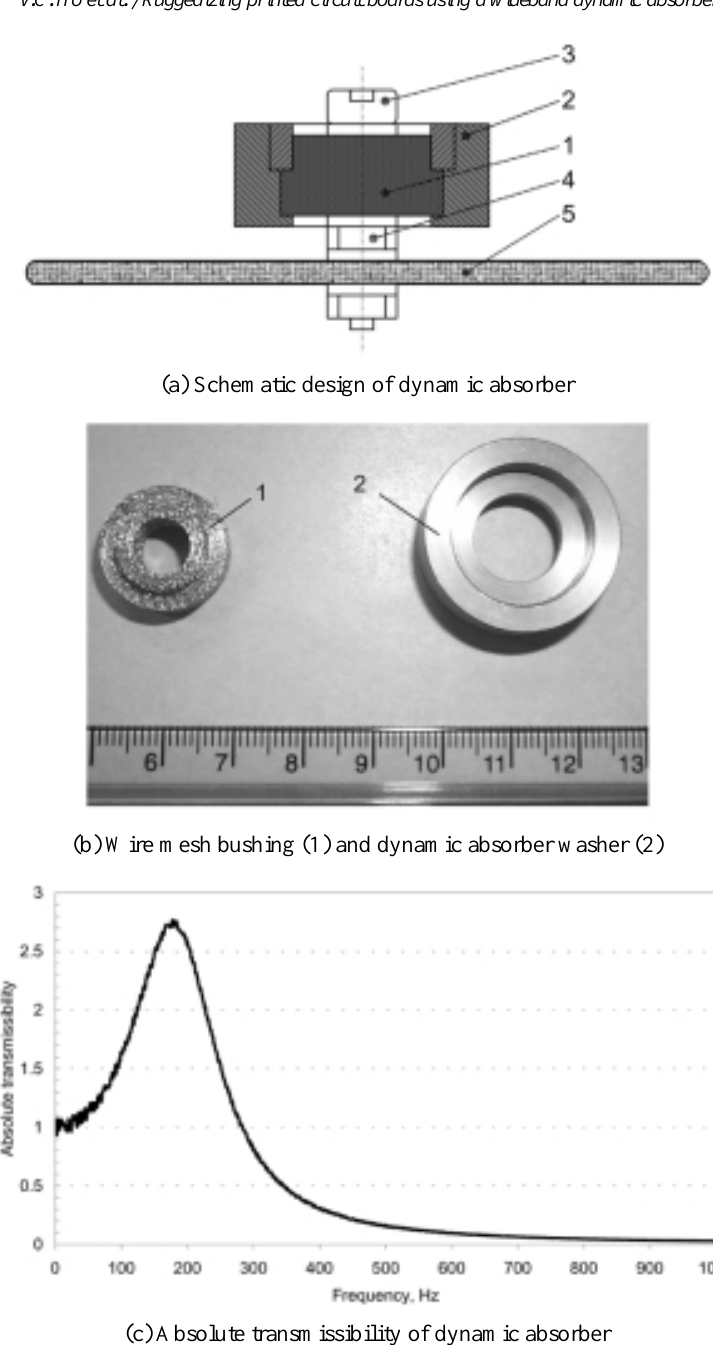
Fig. 7. Design of dynamic absorber. a) Schematic design of dynamic absorber; b) Wire mesh bushing (1) and dynamic absorber washer (2); c) Absolute transmissibility of dynamic